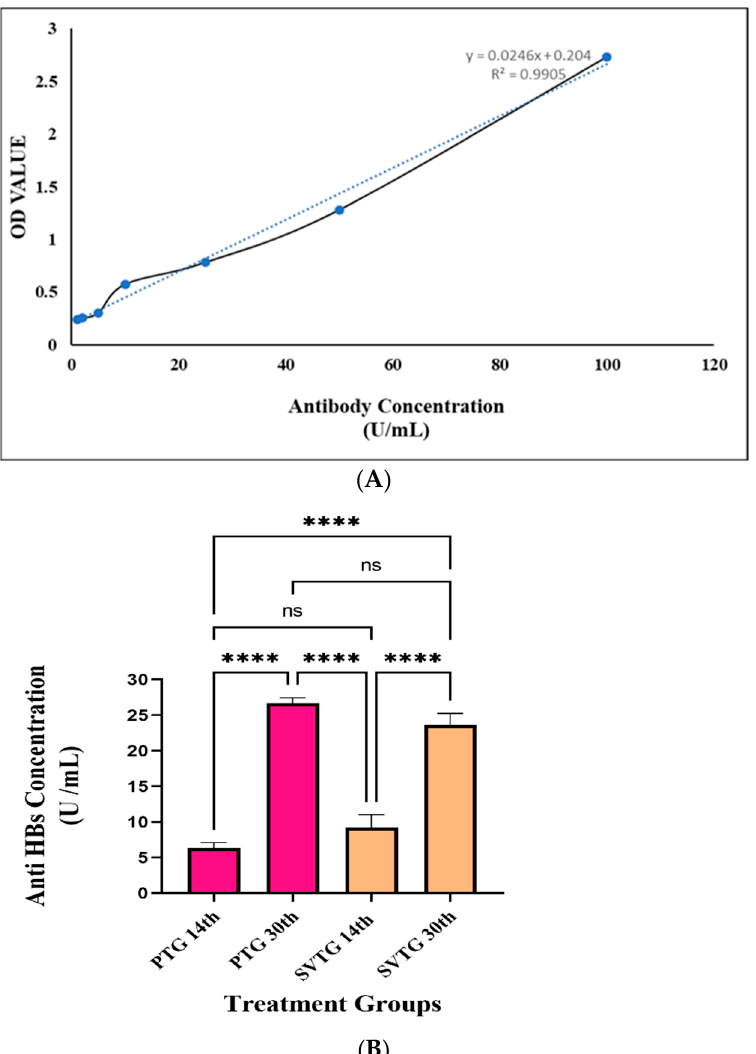
Figure 7. In vivo immunogenicity study; ( A ) standard curve; ( B ) anti-HBs IgG level of various treatment groups . **** The values are very high significant at p < 0.05 level, ns: non-significant at p < 0.05 level